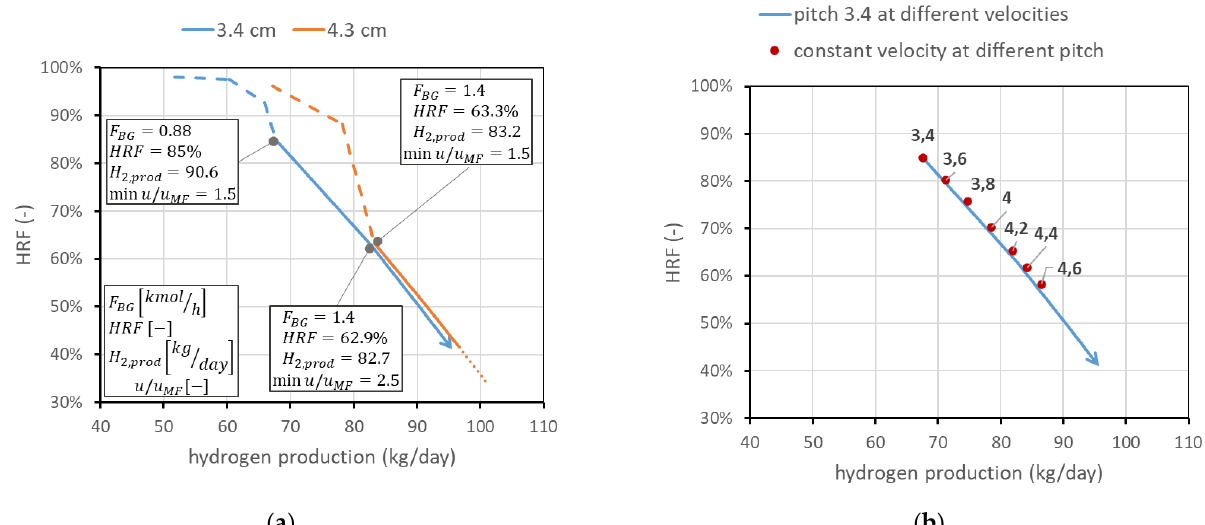
Figure 11. Effect of spacing between the membranes. ( a ) Comparison at different velocities for two different pitches. ( b ) Points at the same velocity (min u / u mf = 1.5) for different pitches (in cm) compared to the line at 3.4 cm pitch and different velocities.